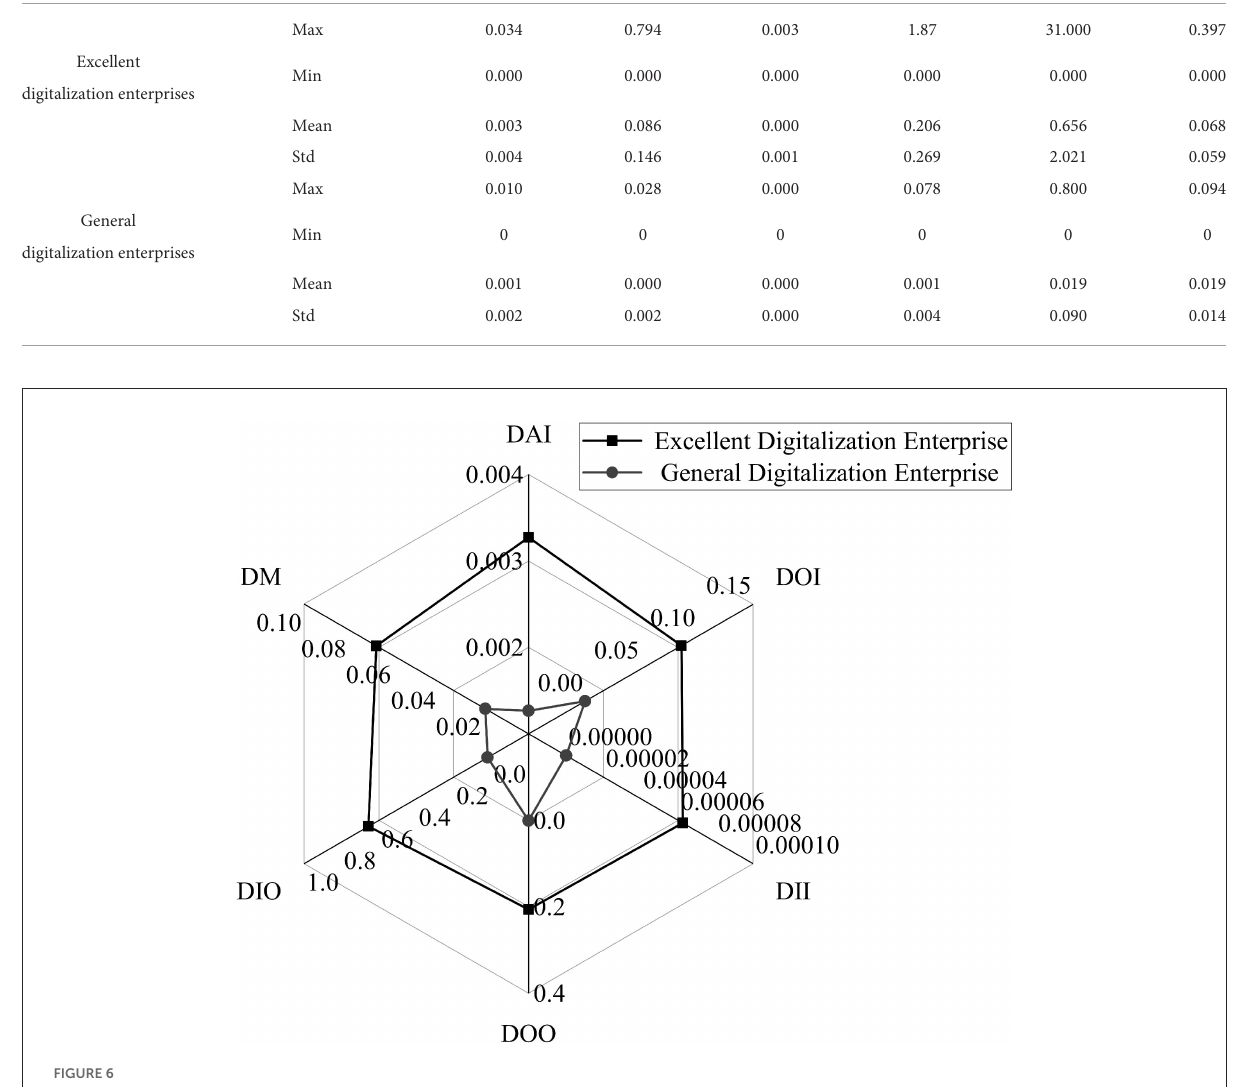
FIGURE6 Radar chart of enterprise digitalization features.